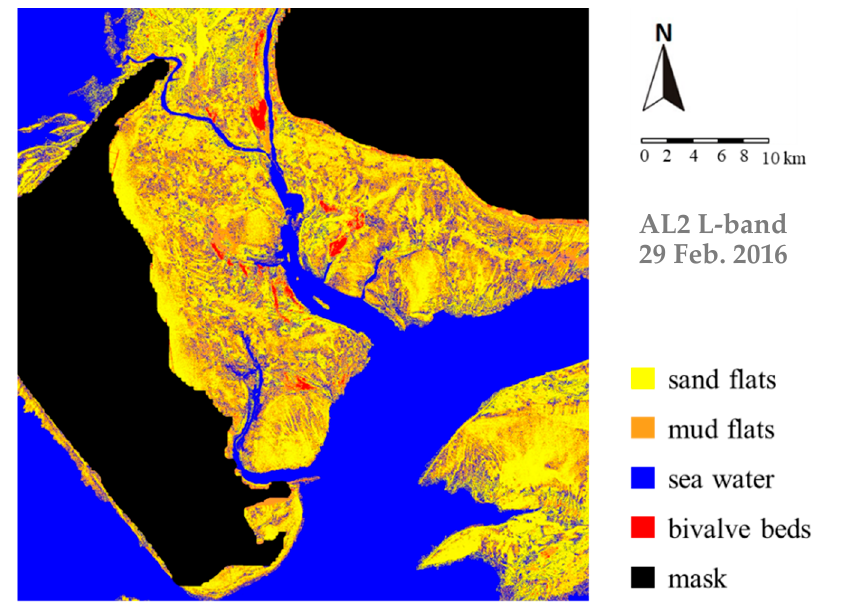
Figure 5 . FCDK-RF classification results based on AL2 L-band quad-pol SAR data acquired on 29 February 2016 at 23:10 UTC, 47 min before the low tide.